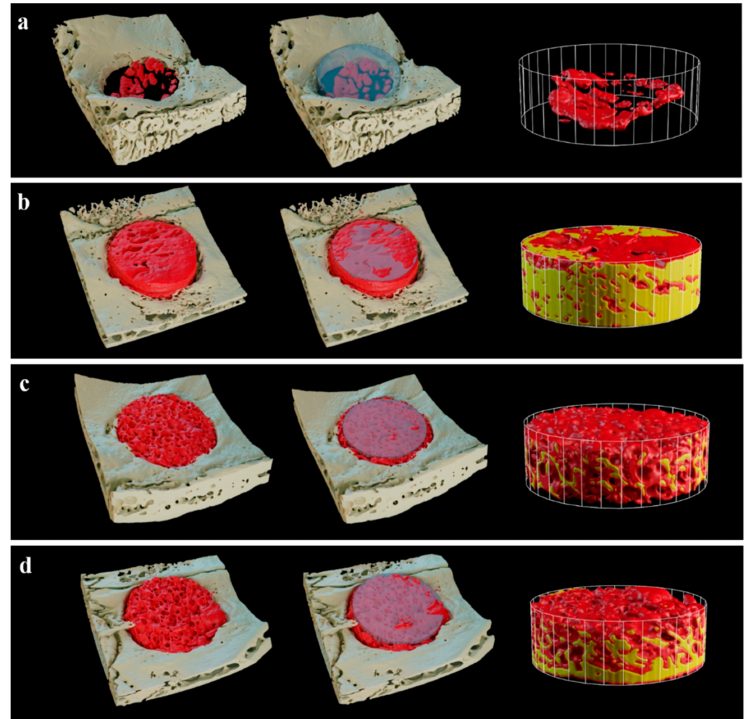
Figure 7. Three-dimensional micro CT images after 8 weeks. ( a ) Control, ( b ) Cortical, ( c ) Cancellous, and ( d ) 2layer groups. Red area: new bone, yellow area: grafted bone